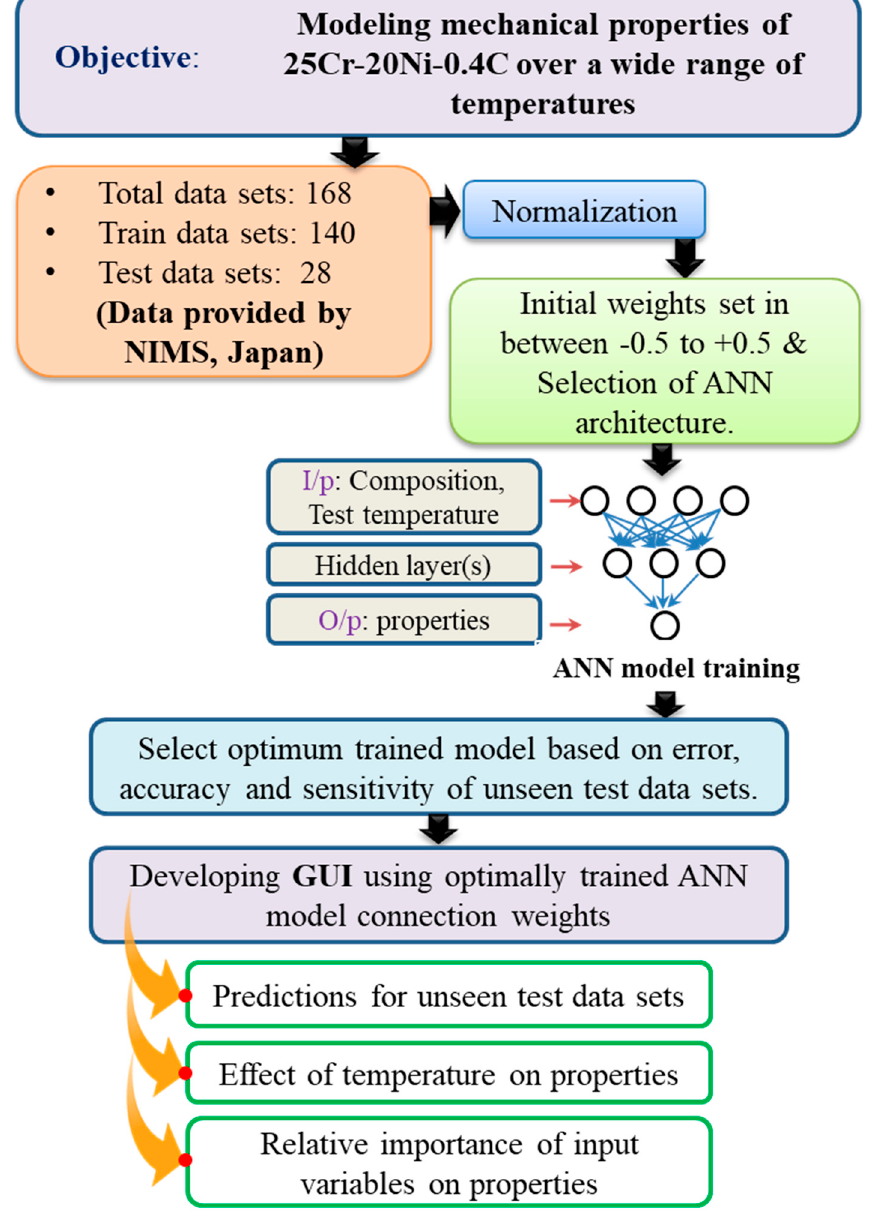
Figure 1. Flow chart describing the various tasks and procedures followed in the present